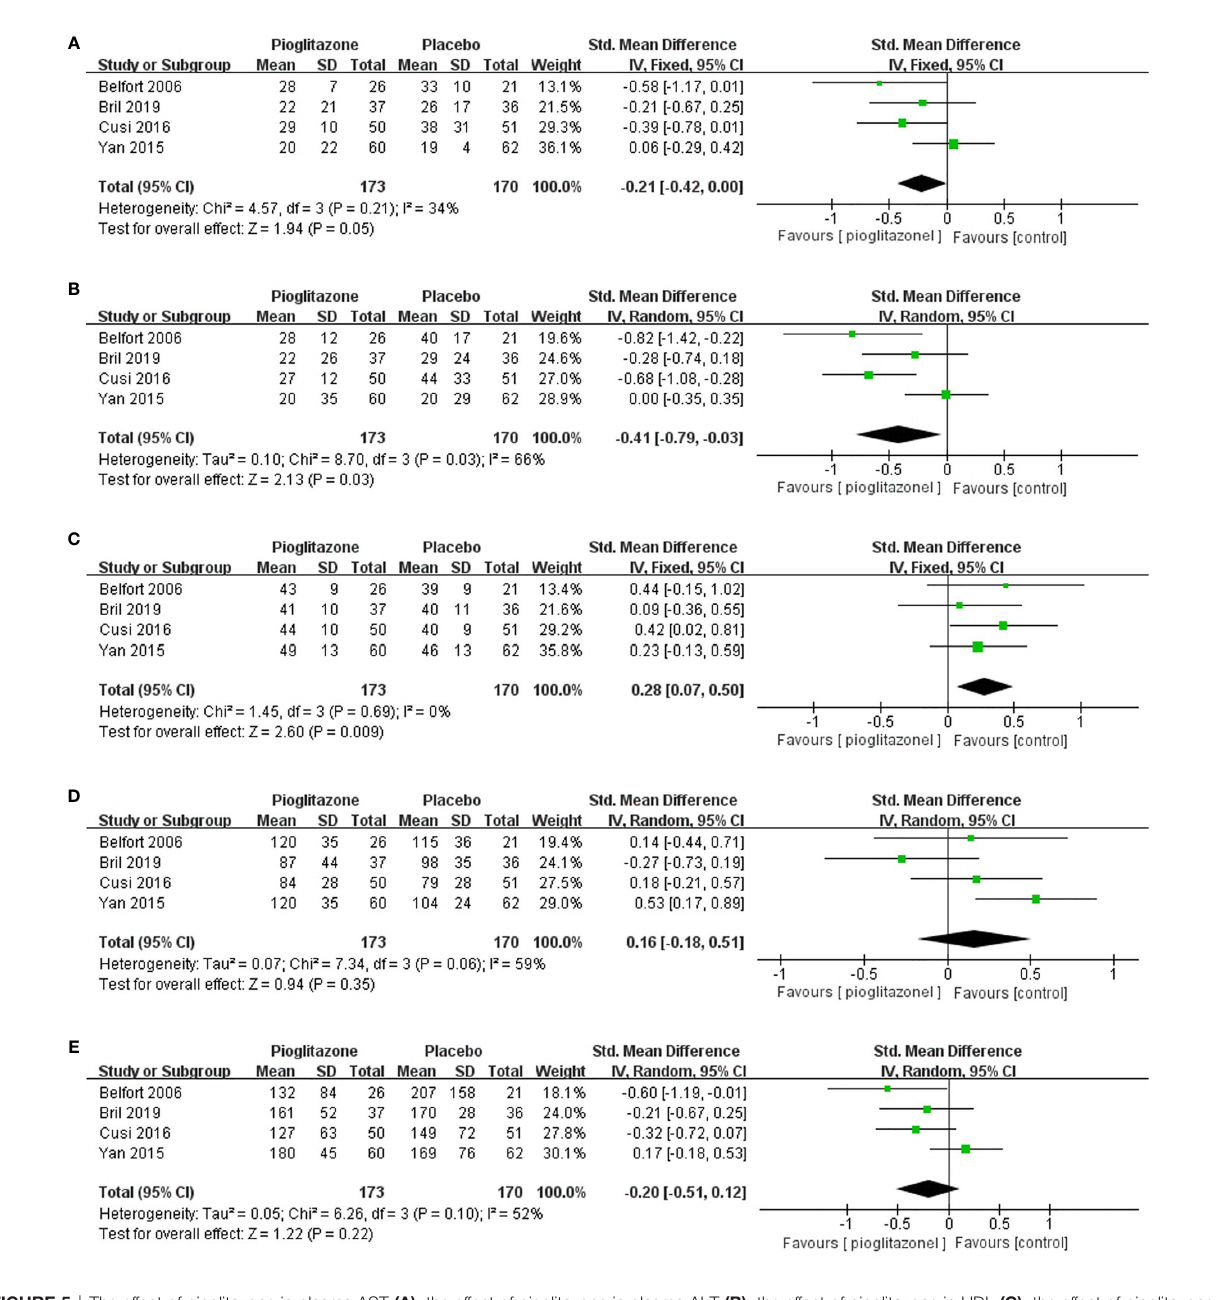
FIGURE 5 | The effect of pioglitazone in plasma AST (A) ; the effect of pioglitazone in plasma ALT (B) ; the effect of pioglitazone in HDL (C) ; the effect of pioglitazone in LDL (D) ; and the effect of pioglitazone on triglyceride levels (E)